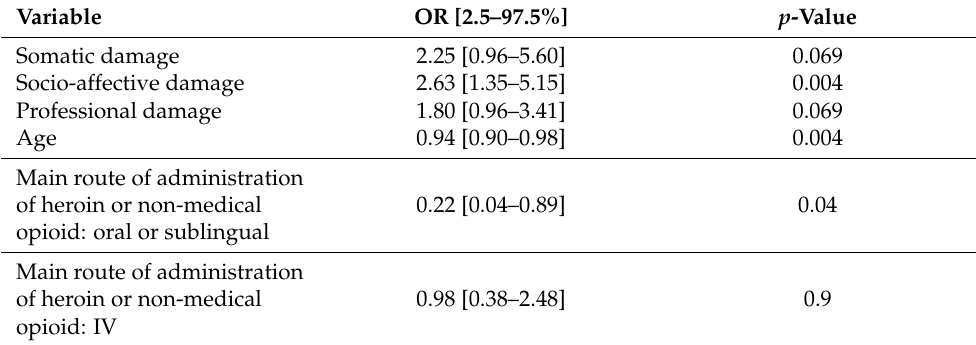
Table 2. Model of clinical profiles of patients on MTD compared to those on BHD n =